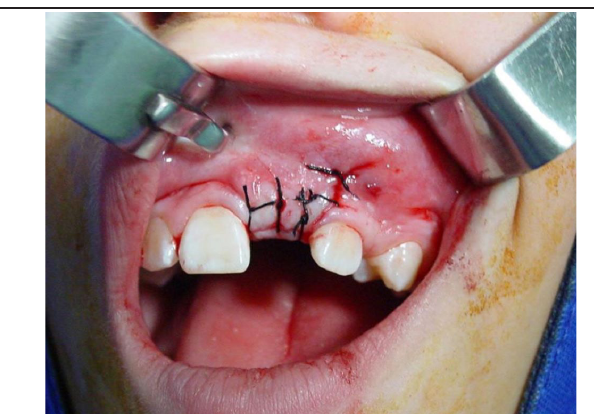
causando inclinação convergente de suas raízes.